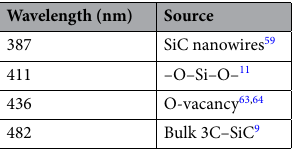
Table 1. The sources of decomposition